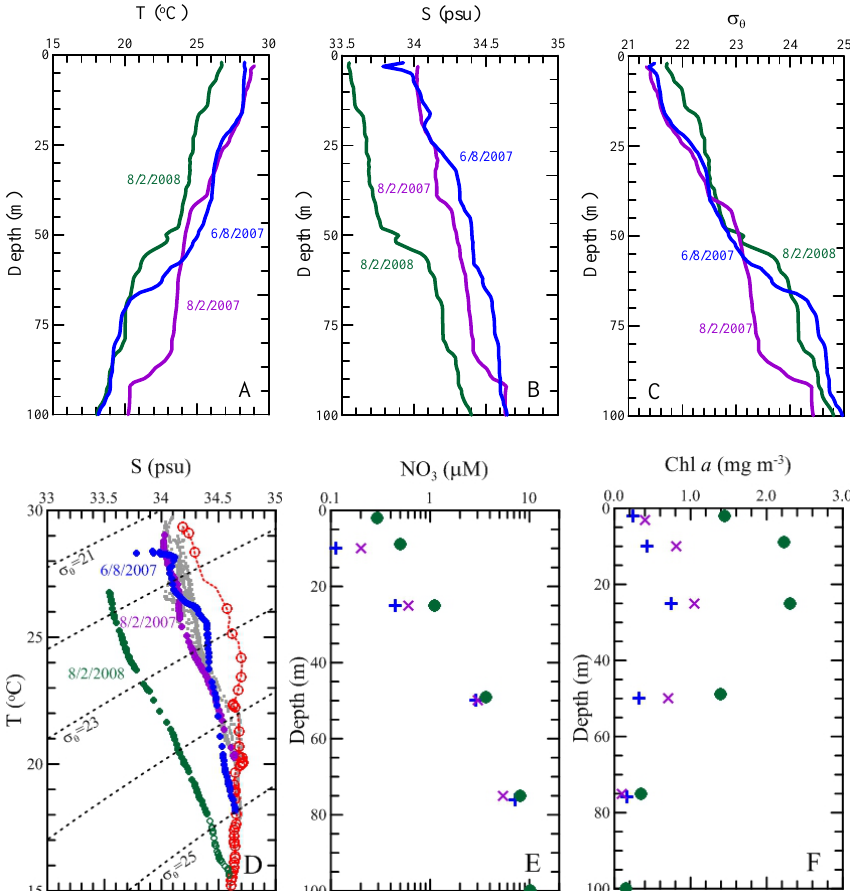
Fig. 3. Vertical profiles of temperature- T (A) , salinity- S (B) , density- σ θ (C) in the study area of the southern East China Sea during non- typhoon periods (blue and purple curves) and after a typhoon event (green curve). Diagrams of T - S - σ θ (D) : a red curve represents the characteristics of the Kuroshio Current; a green curve represents the nature of the upwelled water from the deeper water of the Kuroshio upwelling after a typhoon event; blue, purple, and gray curves represent the upwelled water from the shallow water of the Kuroshio Current under non-typhoon periods;). One can clearly see the colder water from deep water (after typhoon event was brought to the surface deeper than non-typhoon periods. Vertical distributions of nitrate concentration (E) and chlorophyll- a (chl- a) concentration (F) in the study area of the southern East China Sea during non-typhoon periods (blue, purple, and gray symbols) and after a typhoon event (green symbols). Note: nitrate concentrations (below detection limit, ∼ 0µM) in the surface water during non-typhoon periods did not appear because of log